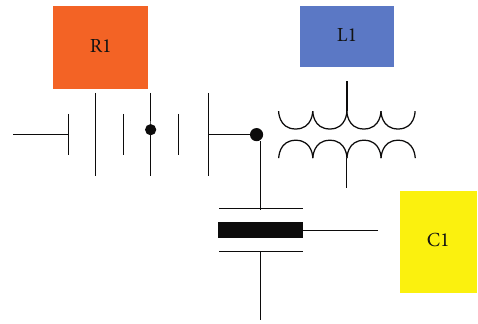
Figure 2: Chip Pad parasitic model.